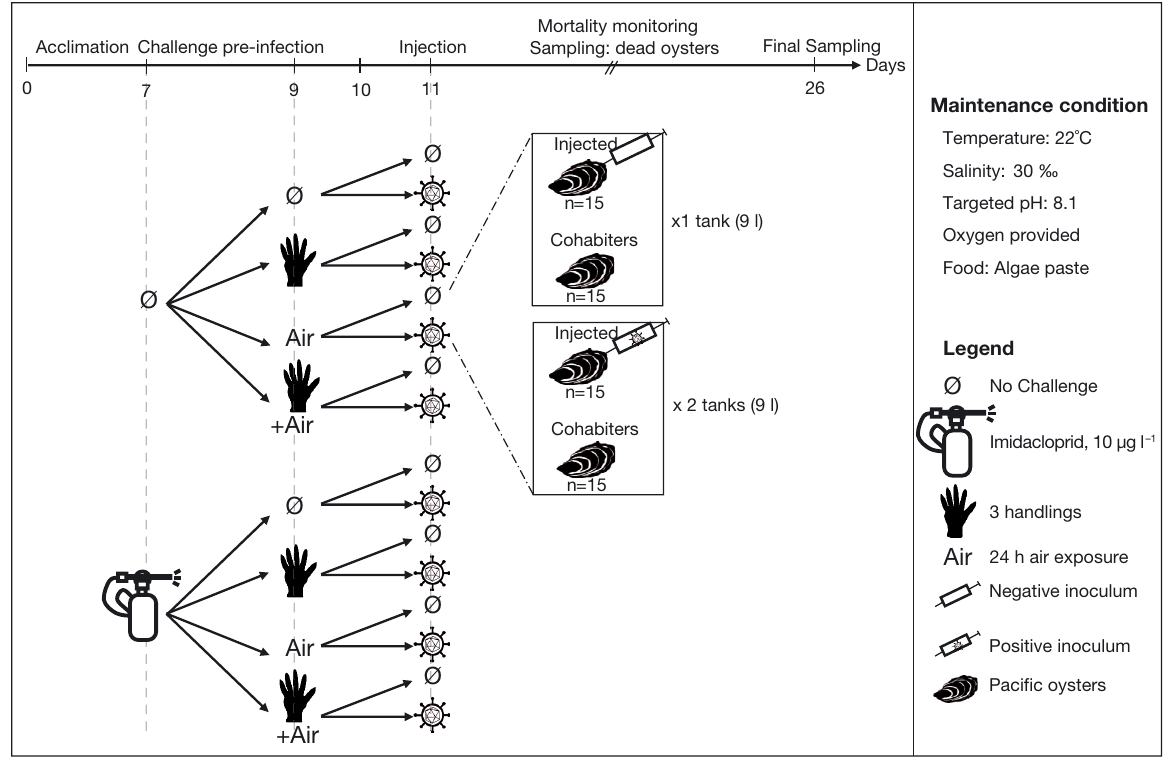
Fig. 1. Experimental design. Pacific oysters were acclimated for 7 d before being exposed to different combination of factors (imidacloprid [10 µg l −1 ], handling, air exposure) prior to challenge with OsHV-1 by injection or cohabitation. Following infec- tion, mortality was monitored for 14 d and dead animals were sampled by